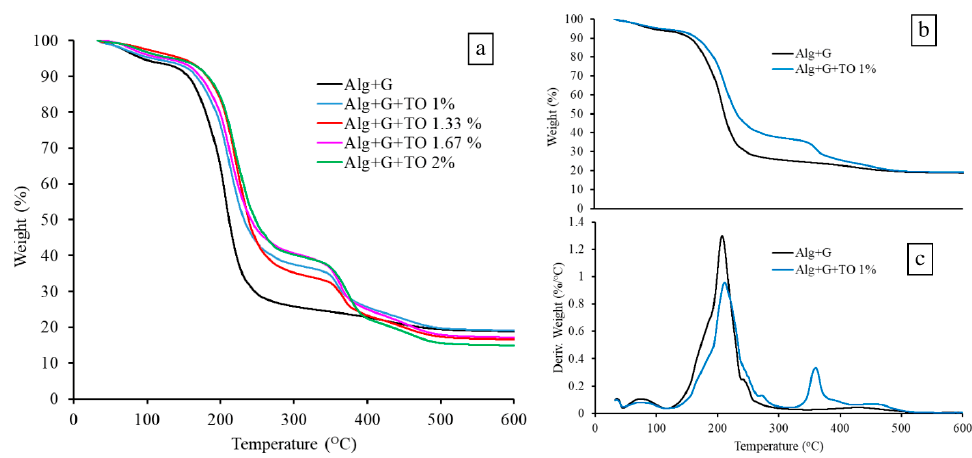
Figure 3. TG ( a , b ) and DTG ( c ) curves of the studied samples.